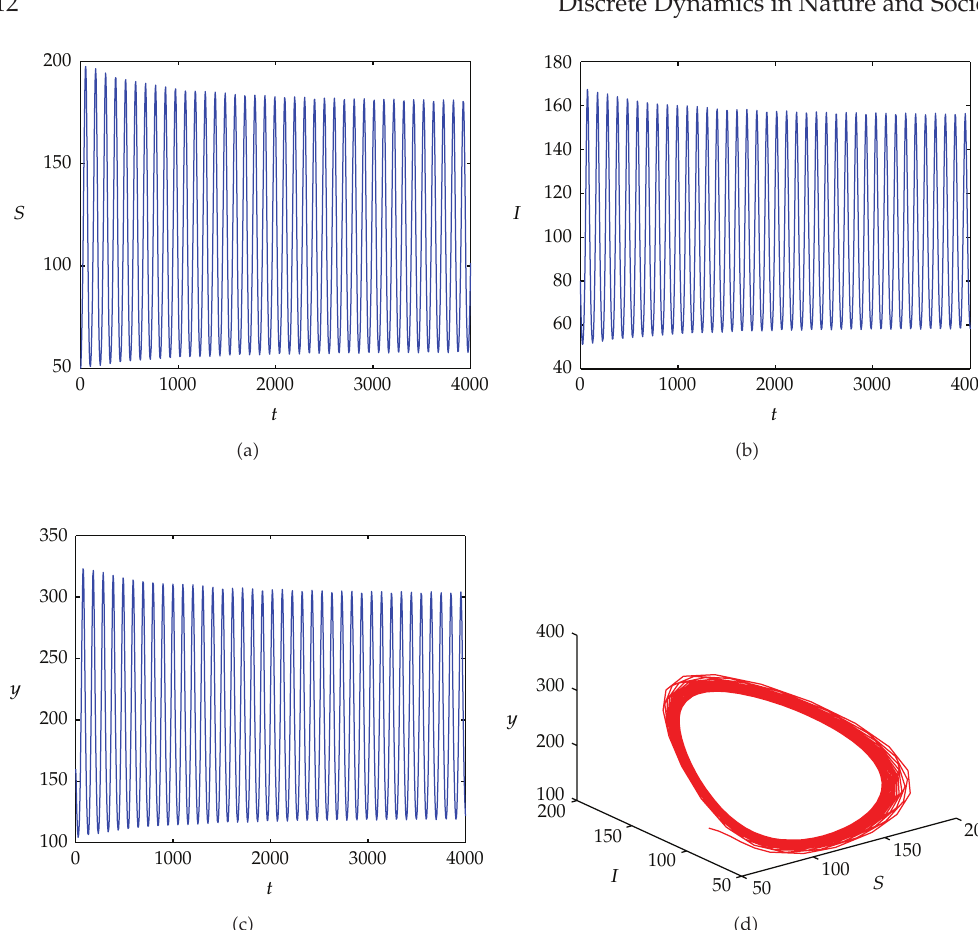
Figure 3: Time evolution of all the population for the model (cid:4) 1.4 (cid:5) with τ (cid:8) 5 . 6 and initial value (cid:4) 50 , 80 , 160 (cid:5) . (cid:4) a (cid:5) , (cid:4) b (cid:5) and (cid:4) c (cid:5) are S , I and y versus t , respectively, and (cid:4) d (cid:5) is the projected S - I - y phase